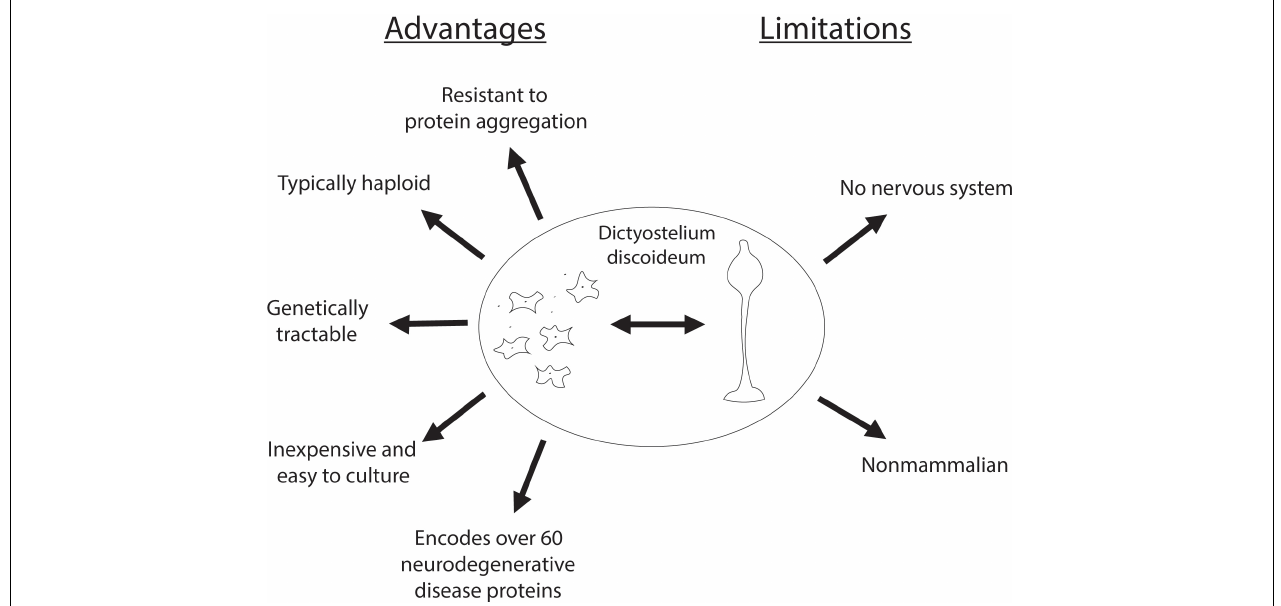
FIGURE 2 | Advantages and limitations of Dictyostelium as a model organism for neurodegenerative diseases. Advantages of using Dictyostelium as a model for neurodegenerative diseases are listed on the left , and its limitations are listed on the right .